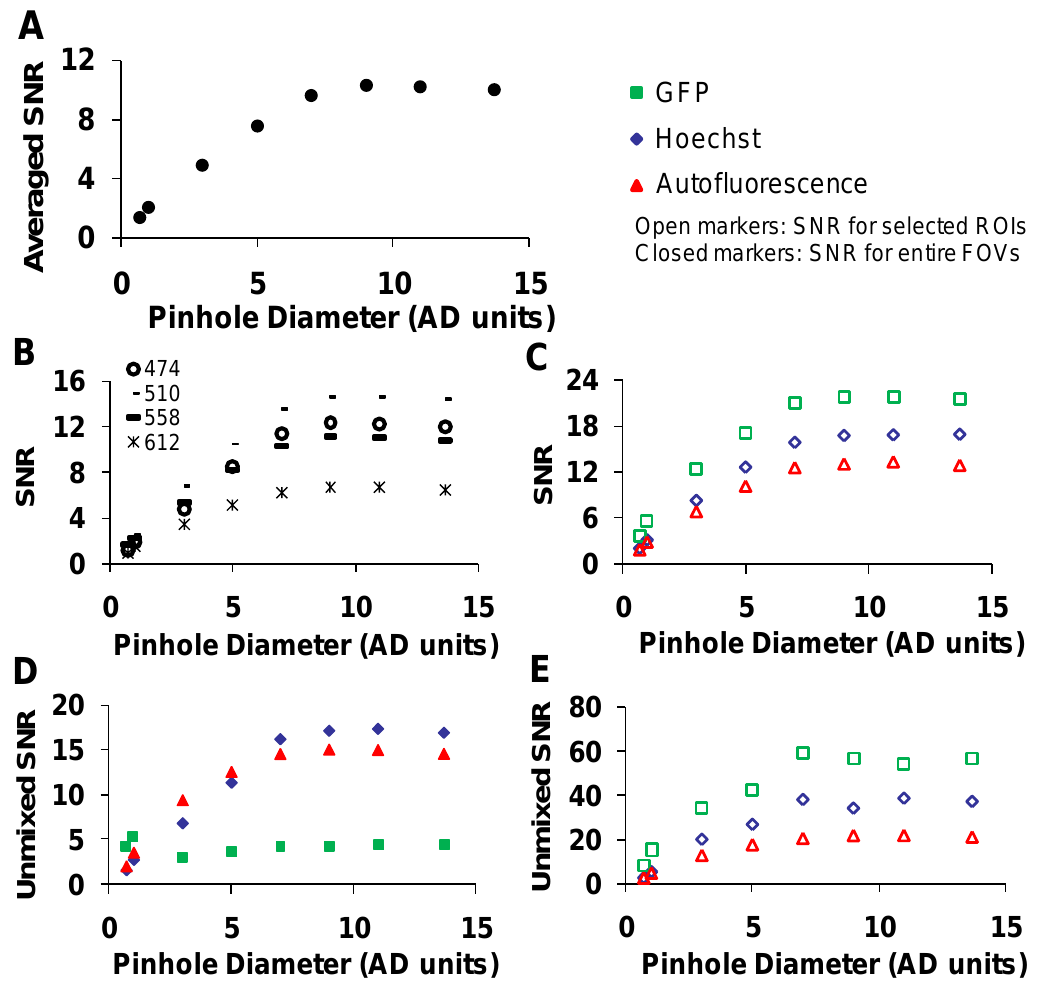
Figure 5. Signal-to-noise characteristics for the confocal system. ( A ) The signal-to-noise ratio(SNR) averaged over a field of view and over all wavelengths; ( B ) the SNR averaged over an entire field of view at selected wavelengths; ( C ) the SNR averaged over all wavelengths for selected regions of interest (ROI) that contained high fluorescence emission from one of the spectral components (labeled respectively in the legend); ( D ) the SNR averaged over an entire field of view for linearly unmixed images; ( E ) the SNR for the same regions of interest as C for linearly unmixed images. Open markers represent SNR in ROIs and closed markers represent SNR in entire field of view (FOV). The pinhole diameter is in airy disk (AD)